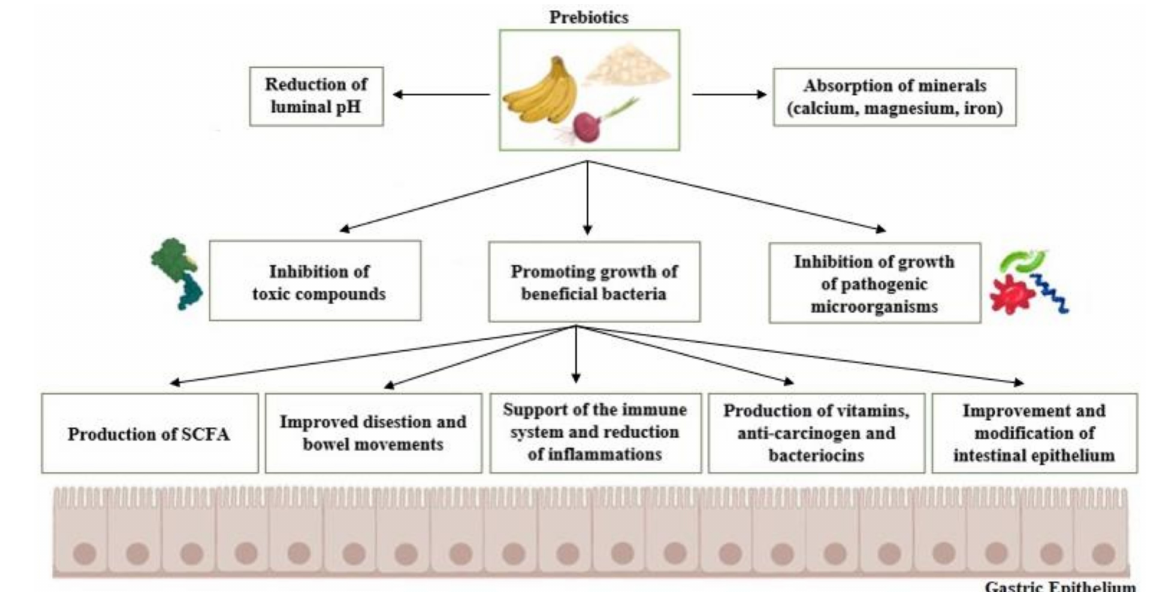
Figure 2. Basic mechanisms of action and benefits of prebiotics. SCFA: Short chain fatty